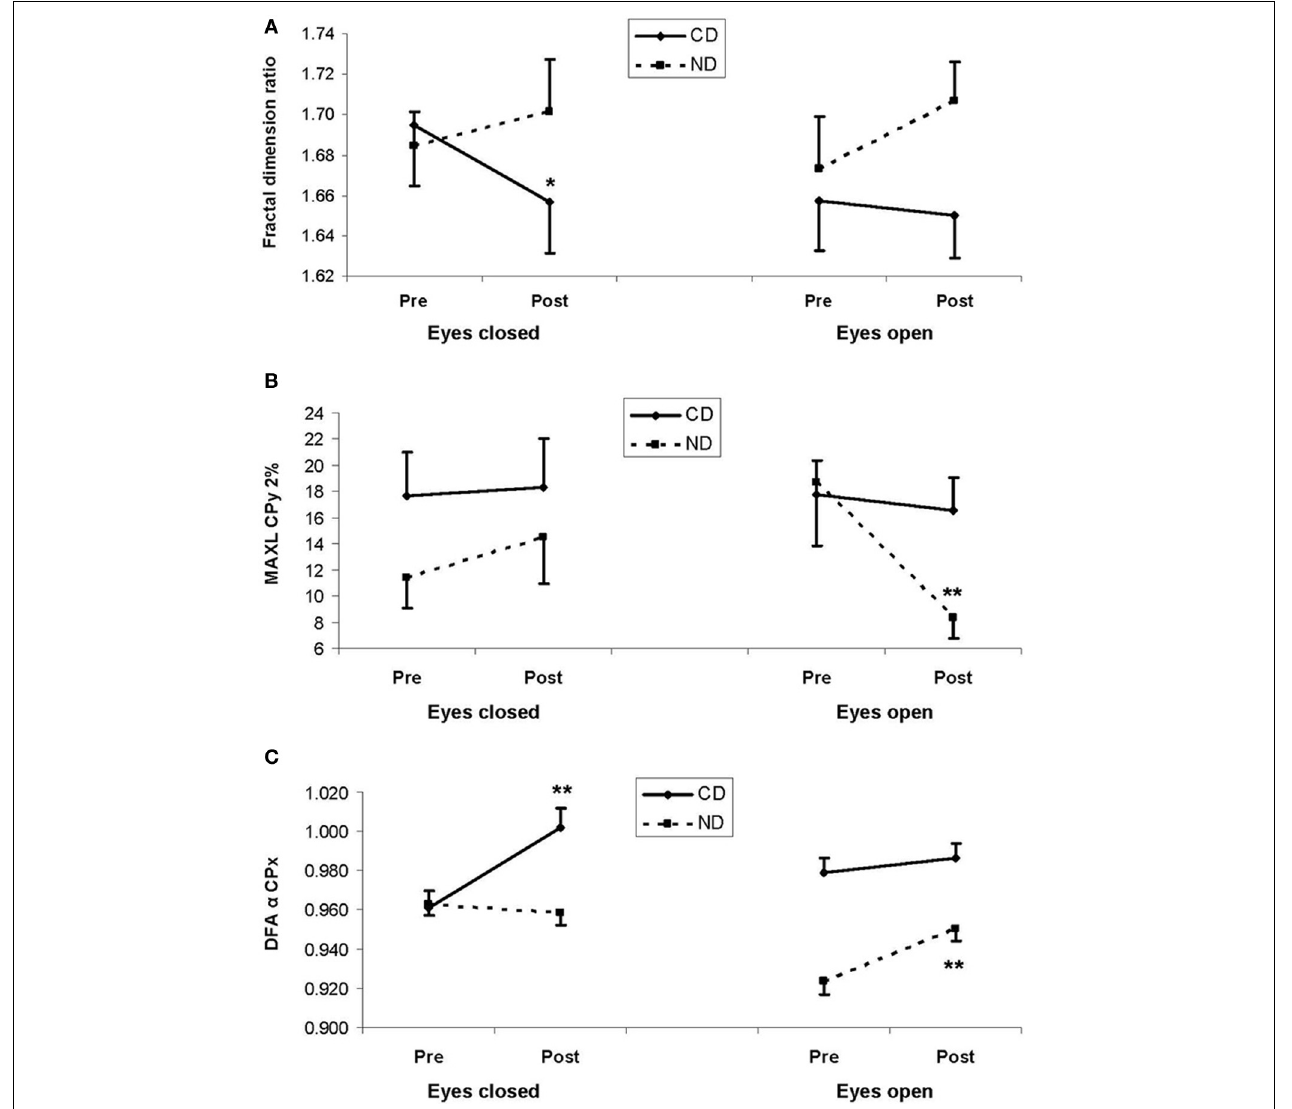
FIGURE 2 | (A) Mean fractal dimension ratio, (B) mean maximal diagonal line (MAXL) for mediolateral movement (CPx) for a 2%-radius from the recurrence quantification analysis, and (C) mean DFA α exponent for mediolateral movement (CPx) from the detrended fluctuation analysis. In the three plots, results are shown as a function of pre-test (Pre) and post-test (Post) periods,